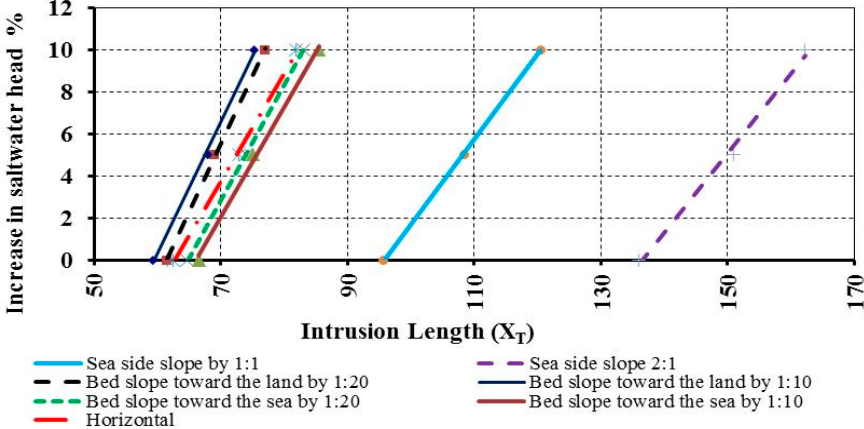
Figure 17. Relationship between intrusion length (X T ) and combination of SLR and recharge for different slopes.